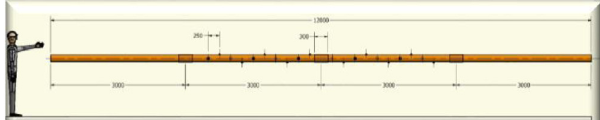
Fig. 5. Test bench.